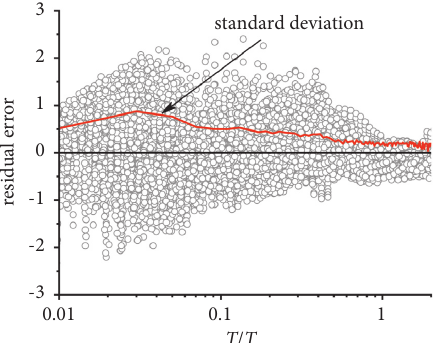
Figure 15: Scatter plot of the residual errors between the real displacement ratios and values estimated by the proposed prediction equation to T / T p